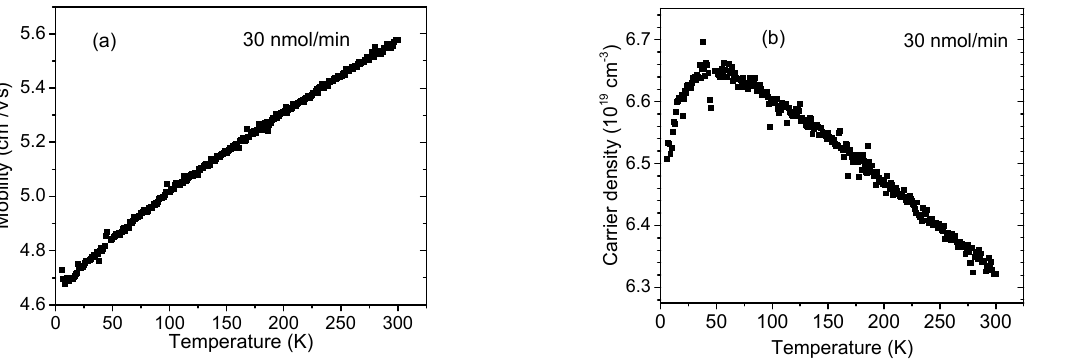
Figure 8. InAlN layer free electron ( a ) mobility and ( b ) concentration. Cp 2 Mg flow during the growth was 30 nmol/min.